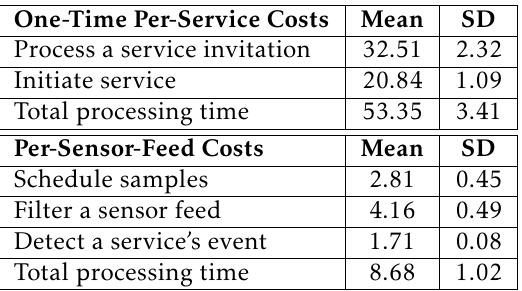
Table 3. Average Processing Time at the Contributor Side in ms